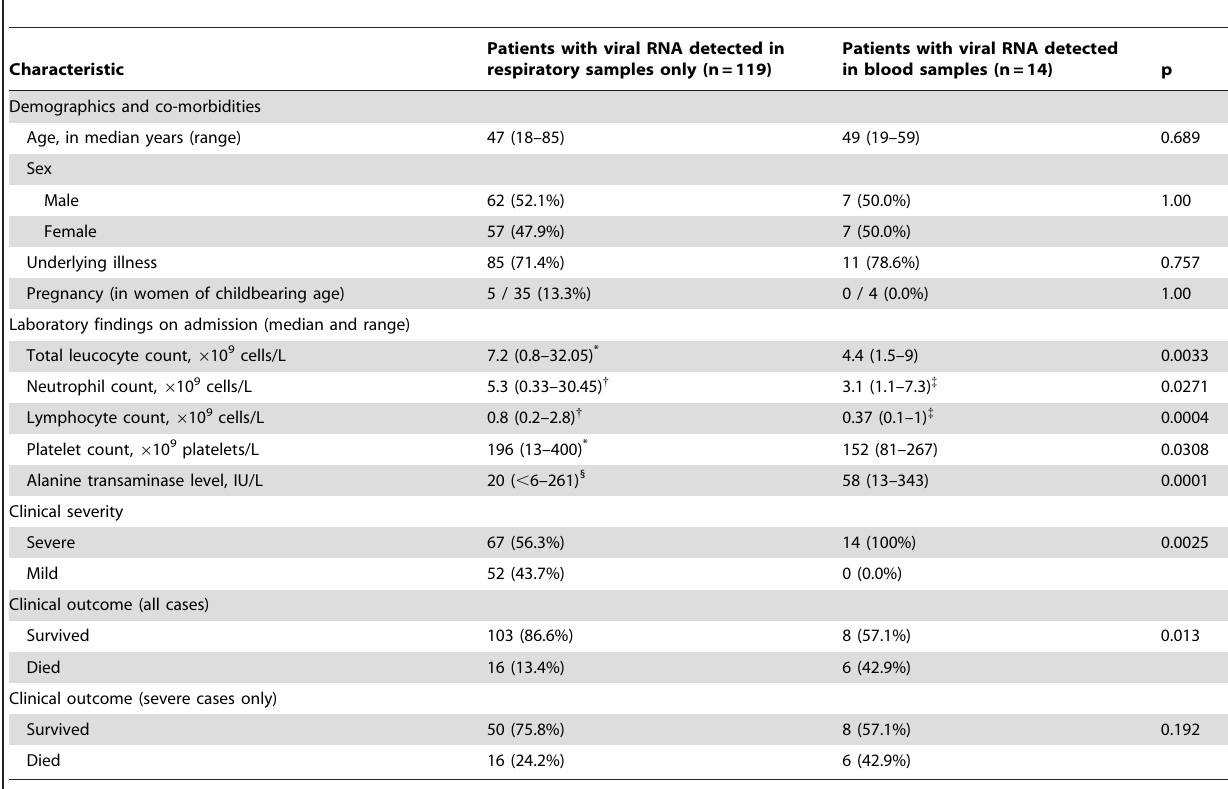
Table 1. Clinical, demographic and laboratory characteristics of hospitalized patients with pandemic influenza A/H1N1/2009 virus